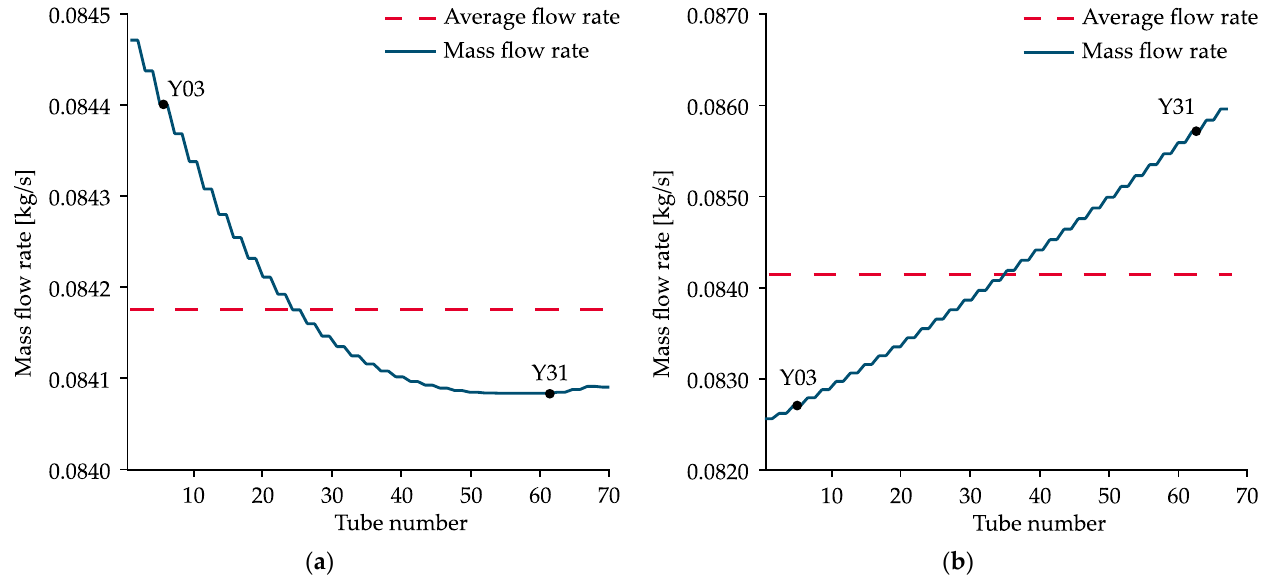
Figure 20. Superheated steam distribution in the tubular system with: ( a ) U-arrangement; ( b ) Z-arrangement. The observed differences in flue gas flow fields at the inlet were negligible, but a major discrepancy was spotted in the obtained temperature fields in the respective portions of the Y03 and Y31 channels. Obviously, the assessments of tube-side flow non-uniformity produced opposite distribution curves (Figure 20) in the case of U- and